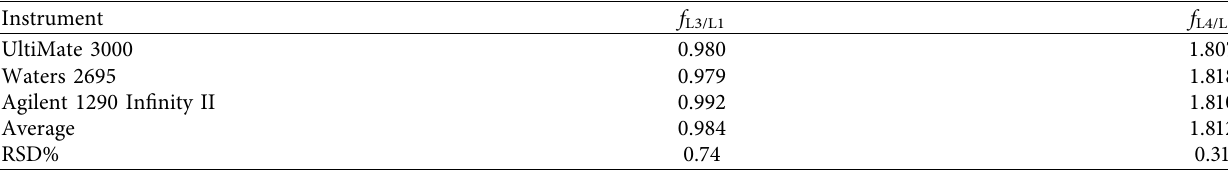
Table 7: Effect of different brands of HPLC instrument on f